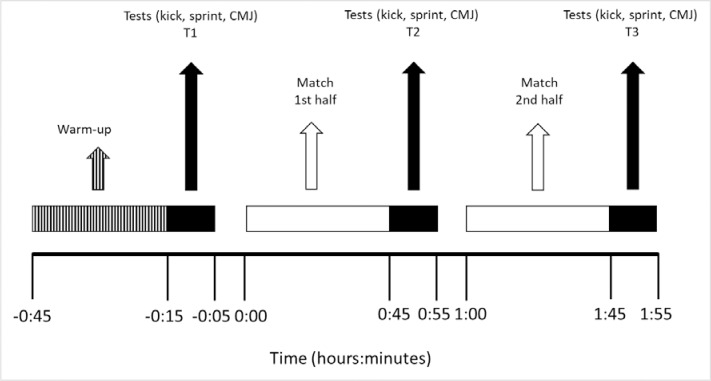
Timing and order of tests.